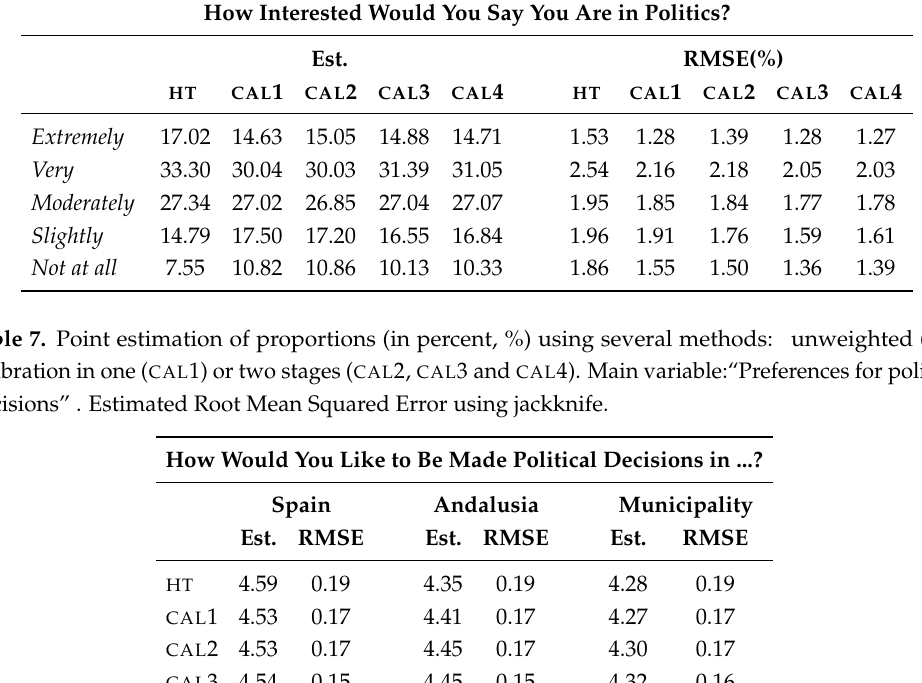
Table 6. Point estimation of proportions (in percent, %) using several methods: unweighted ( HT ), calibration in one ( CAL 1) or two stages ( CAL 2, CAL 3 and CAL 4). Main variable: “Interest in politics”. Estimated Root Mean Squared Error using jackknife (in percent, %).